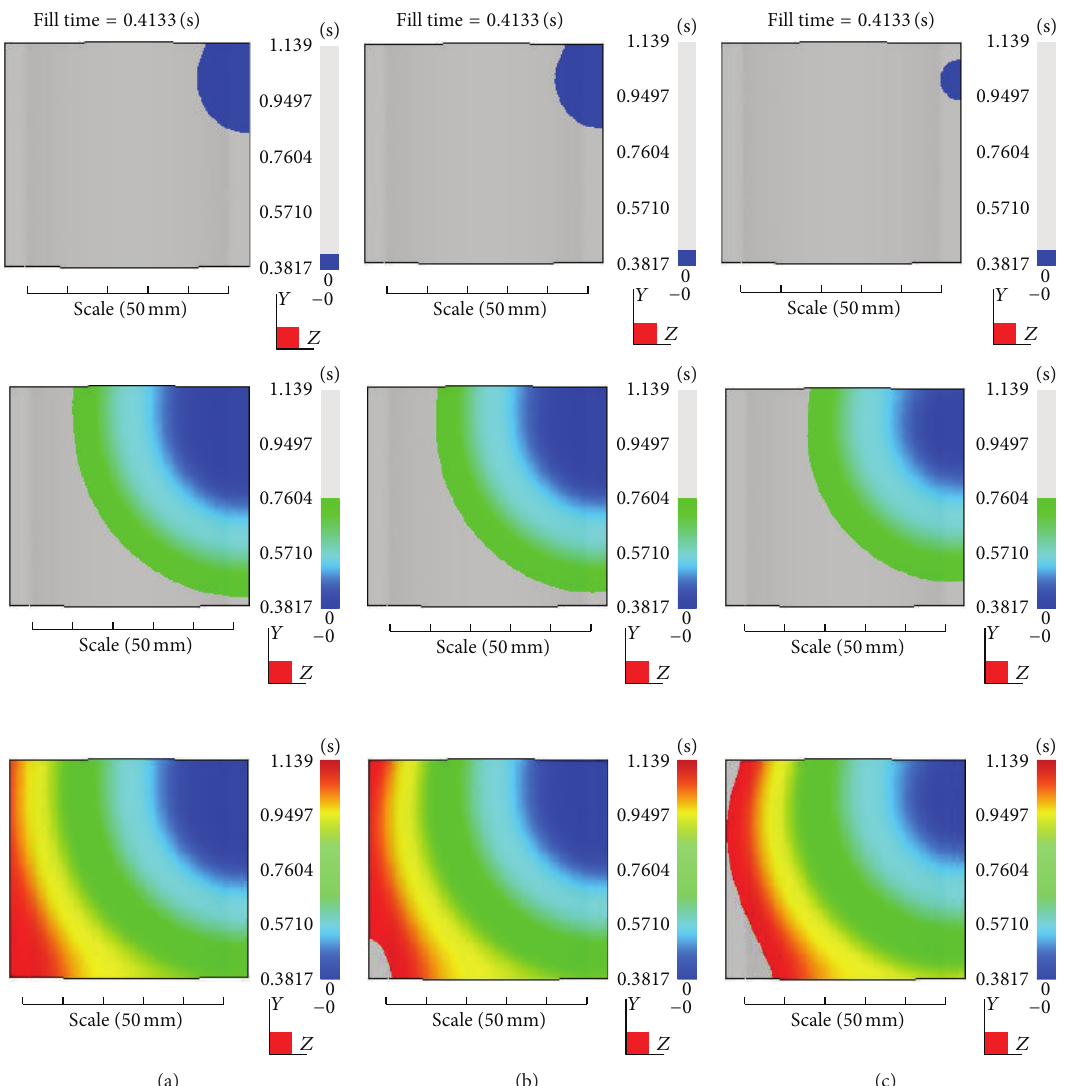
Figure 4: Filling phase for (a) PP, (b) PP + 10 wt% glass fibre, and (c) PP + 50 wt%